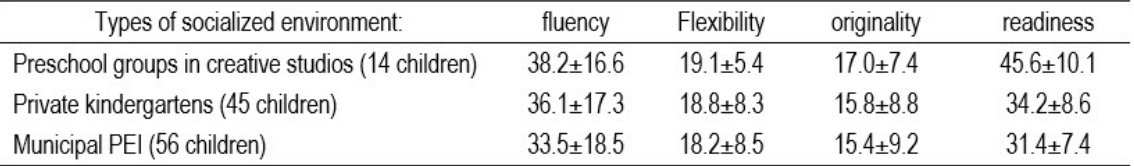
Average values and standard deviations of raw creativity indicators of children aged 5-6